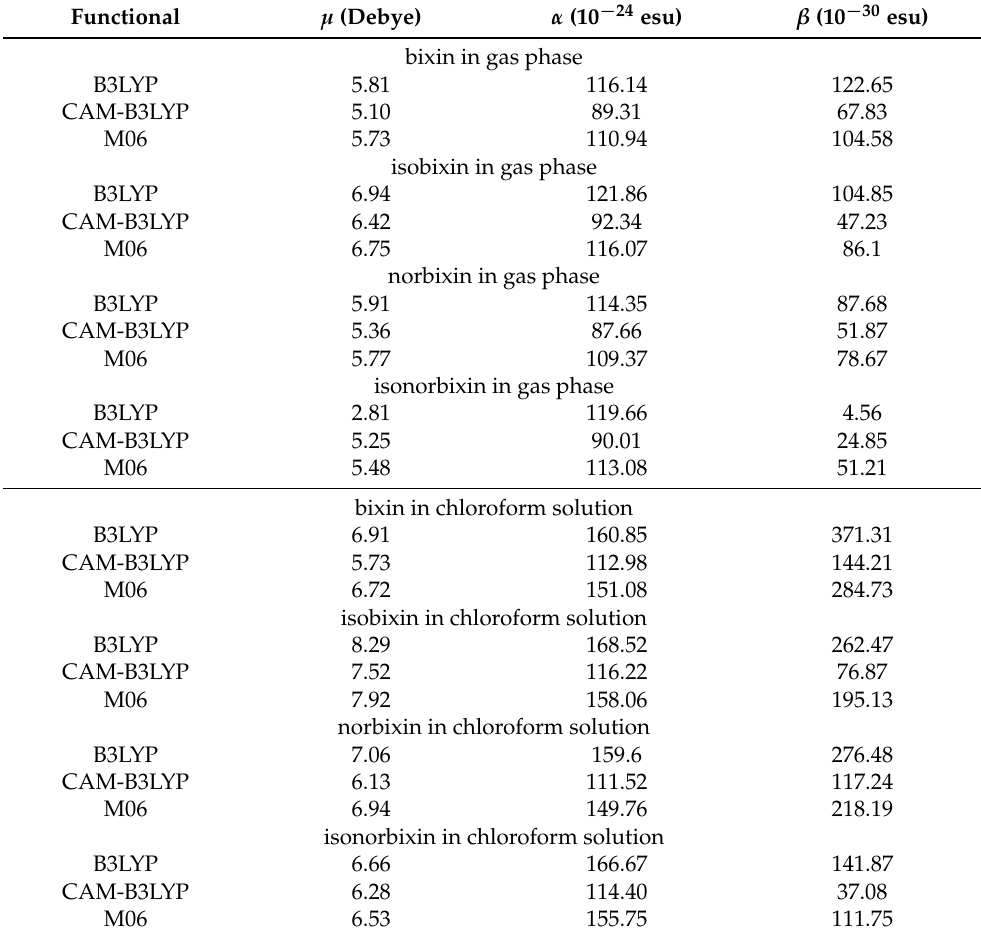
Table 3. Dipole moment ( µ ), average linear polarizability ( α ), and vector component of the first ( β vec ) hyperpolarizability of the dyes in gas phase and chloroform solution. These results were obtained by employing the 6-31+G(d,p) basis